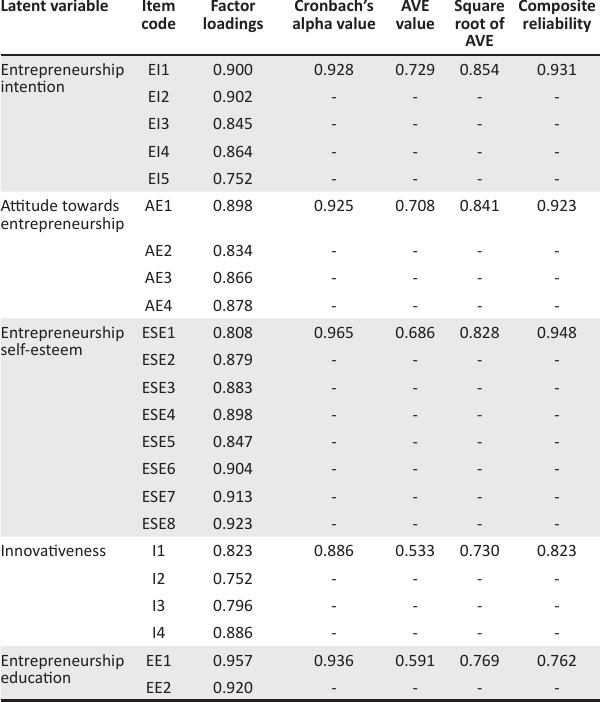
TABLE 3: Reliability and validity results.